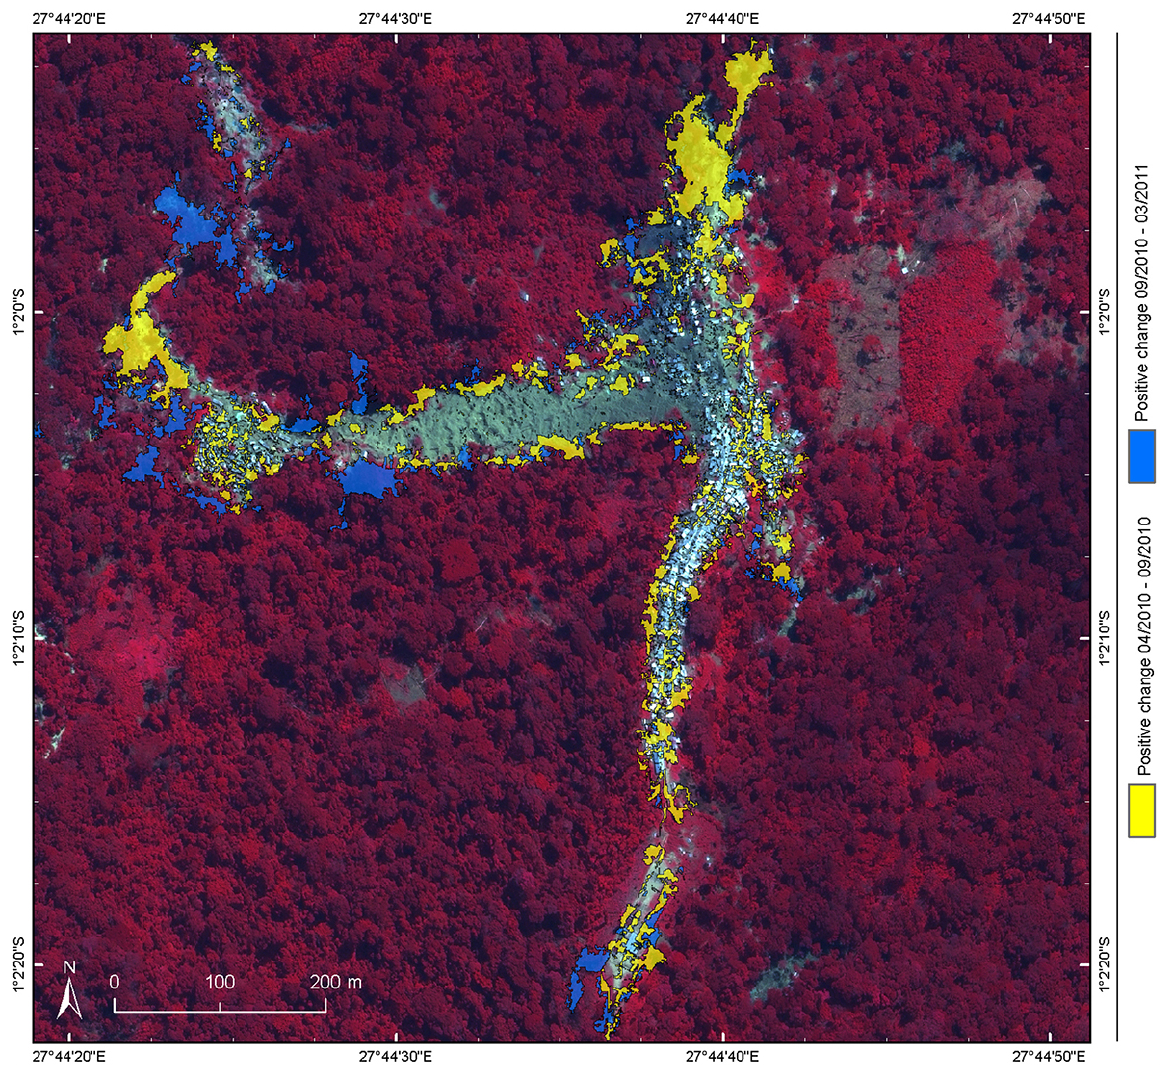
Figure 11. Yellow color represents increase (positive change) in surface area from April to September 2010; blue color shows increase (positive change) in surface area from September 2010 to March 2011. Negative changes are merely negligible and thus not